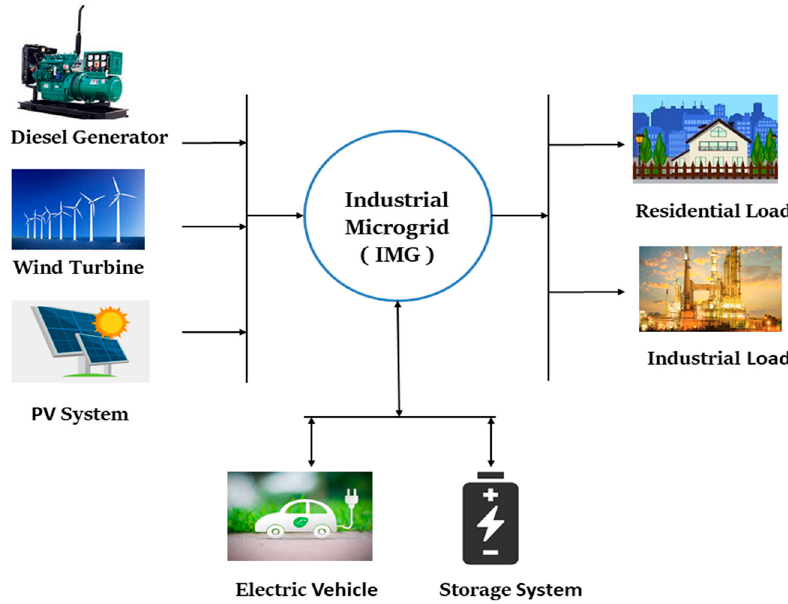
Figure 1. Conceptual view of an industrial microgrid.